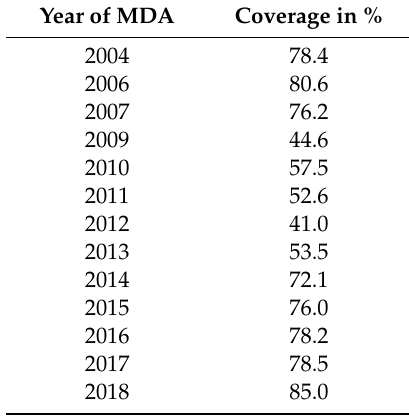
Figure 4. Proportion of individuals who did not use MDA in the last round of distribution by age group ( A ) and by villages ( C ); and prevalence of CFA by age group ( B ) and by village of residence ( D ). The color bands represent Boma, Doda, Kwale, Manza, Maramba, and Mayomboni wards. Data on MDA overage for the Mkinga district between 2004 and 2018, as obtained from NTDCP, Table 4. MDA coverage in Mkinga District—2004–2018. Source: [31]